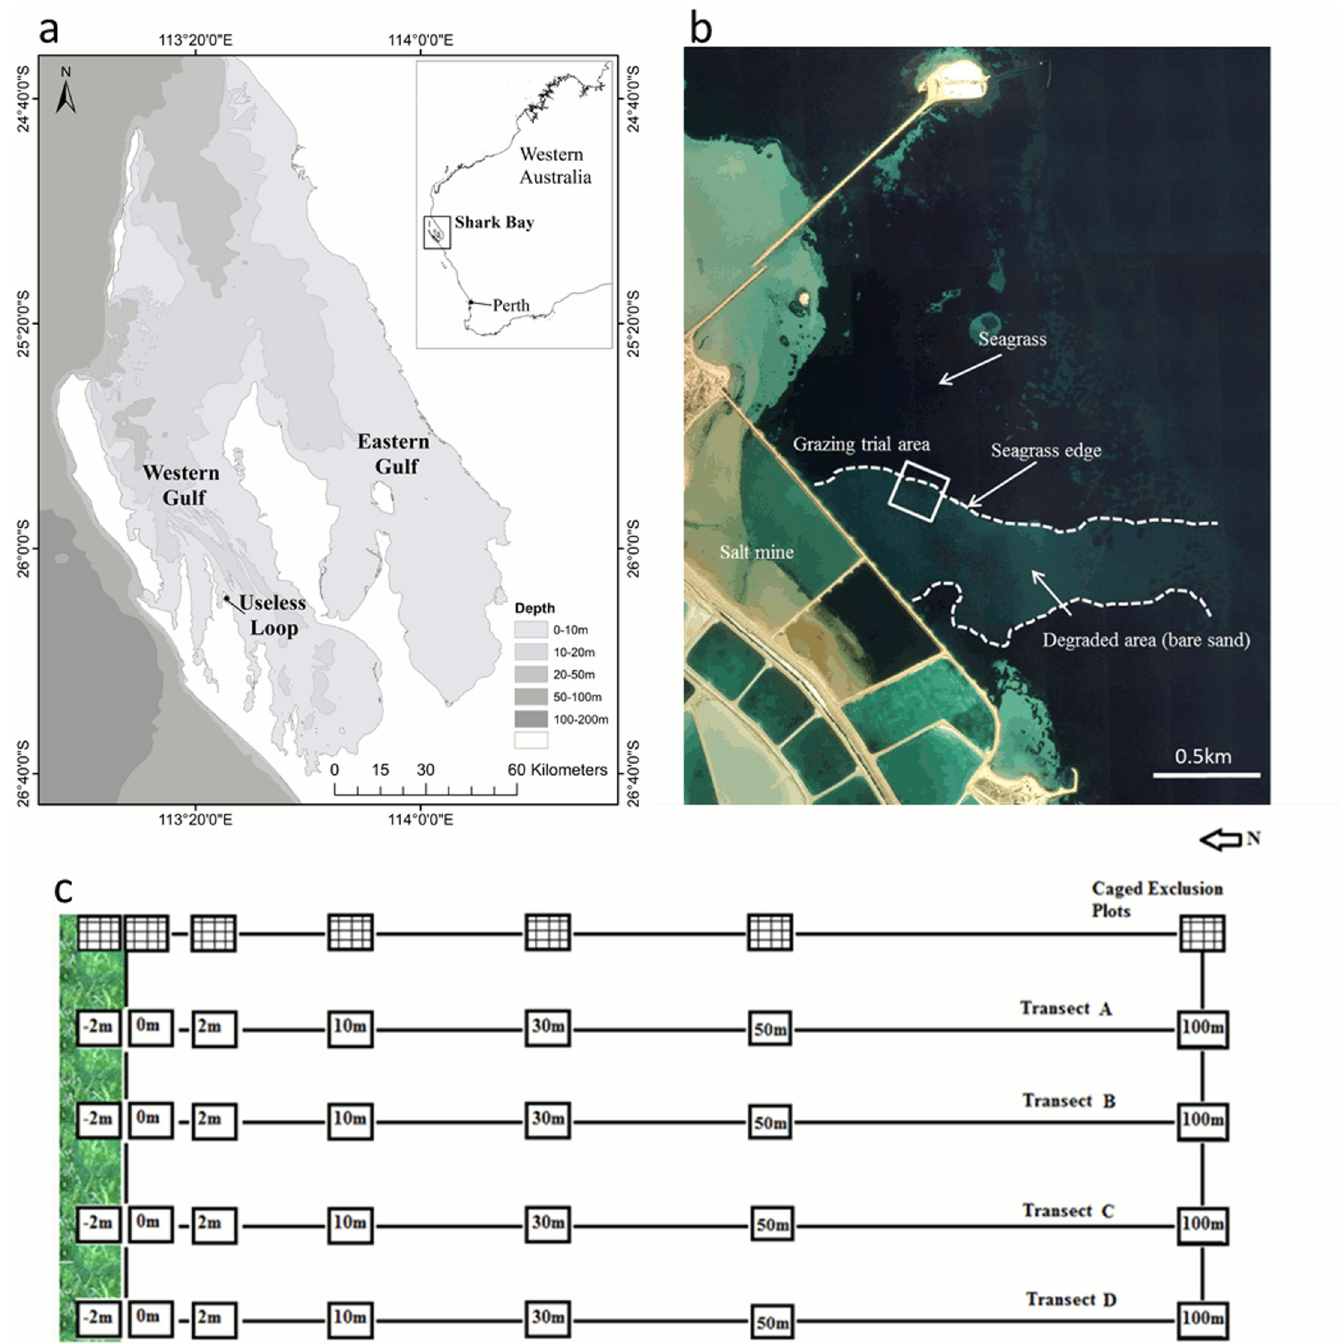
Fig 1. Map of Useless Loop, Shark Bay (a). Twenty five years after bitterns released from a nearby solar salt facility affected 120 ha of seagrass — dotted line indicates approximate edge of the degraded area (b). Grazing trial area (white box) located on the northern edge of the degraded seagrass habitat. Experimental design of grazing trial